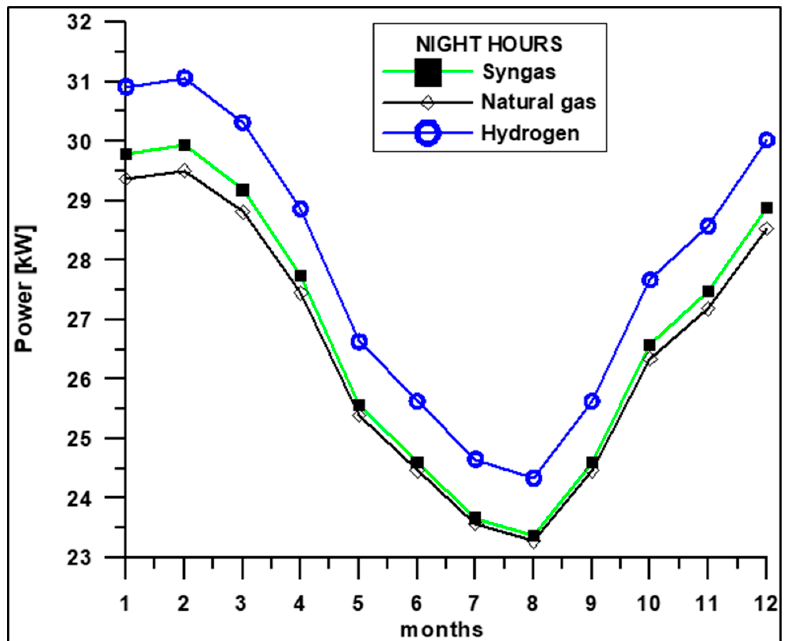
Figure 14. Heat transfer in cogeneration unit during year.